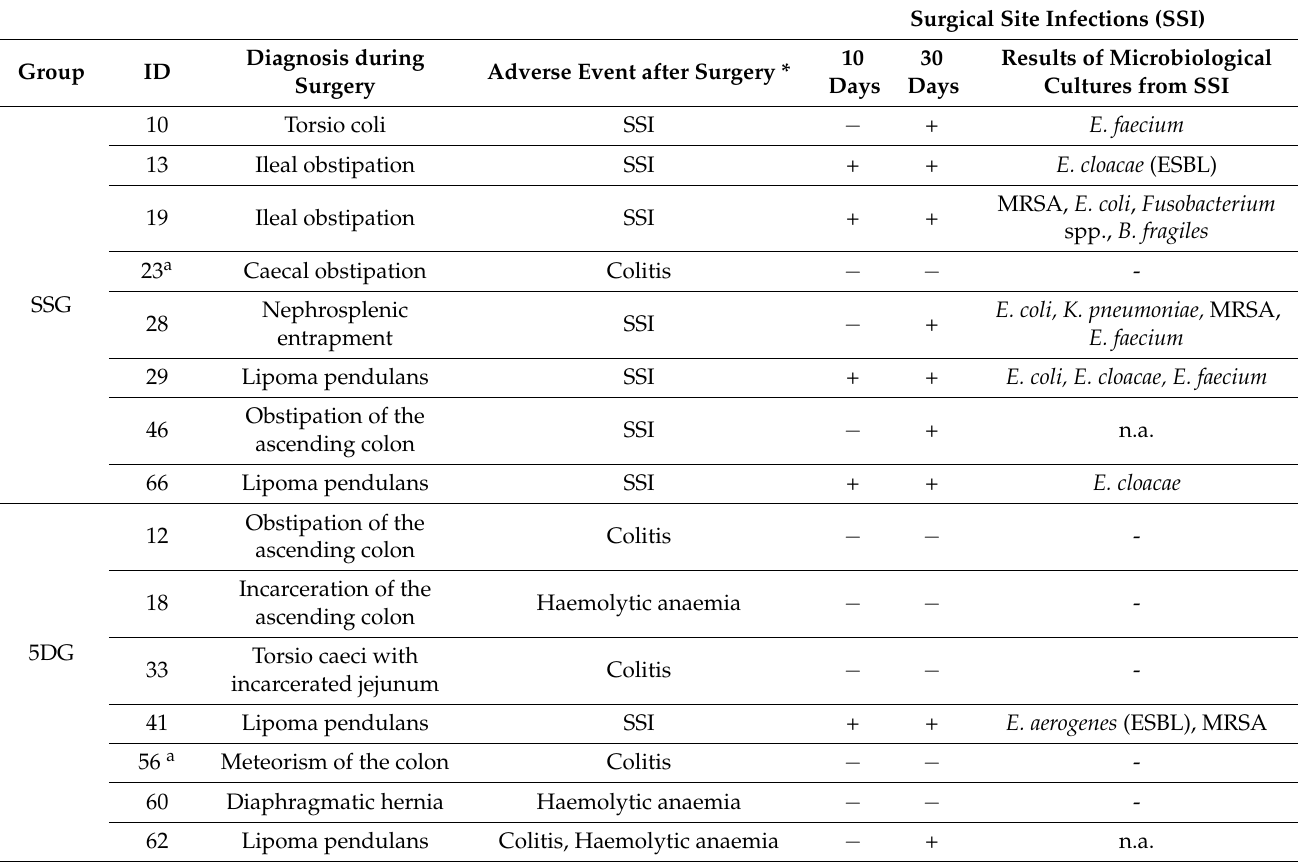
Table 1. Adverse events following colic surgery possibly associated with the antibiotic regimen (p.o. = postoperatively).